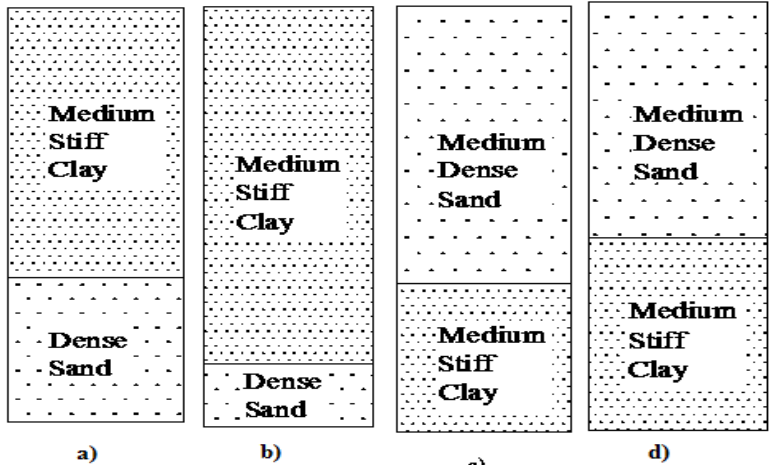
Fig. 1. Different types of layered soil a) Soil type-1, b) Soil type-2, c) Soil type-3, d) Soil type-4. Different soil parameters for this research. Parameters Unit Medium Stiff Medium Dense Dense Referenc Clay Sand Sand e Angle of internal friction Degre 25 35 40 [21] (Φ) Modulus of elasticity (E) kN/m 2 10,000 35,000 70,000 [22] [23]